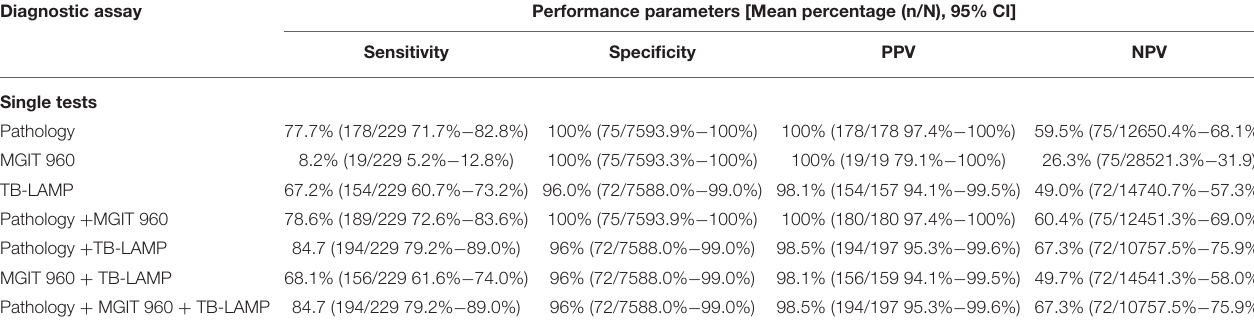
TABLE 3 | Performance of TB-LAMP, MGIT960 culture and pathology as single tests and combined tests in the diagnosis of TB empyema with CCRS as the reference standard. Diagnostic